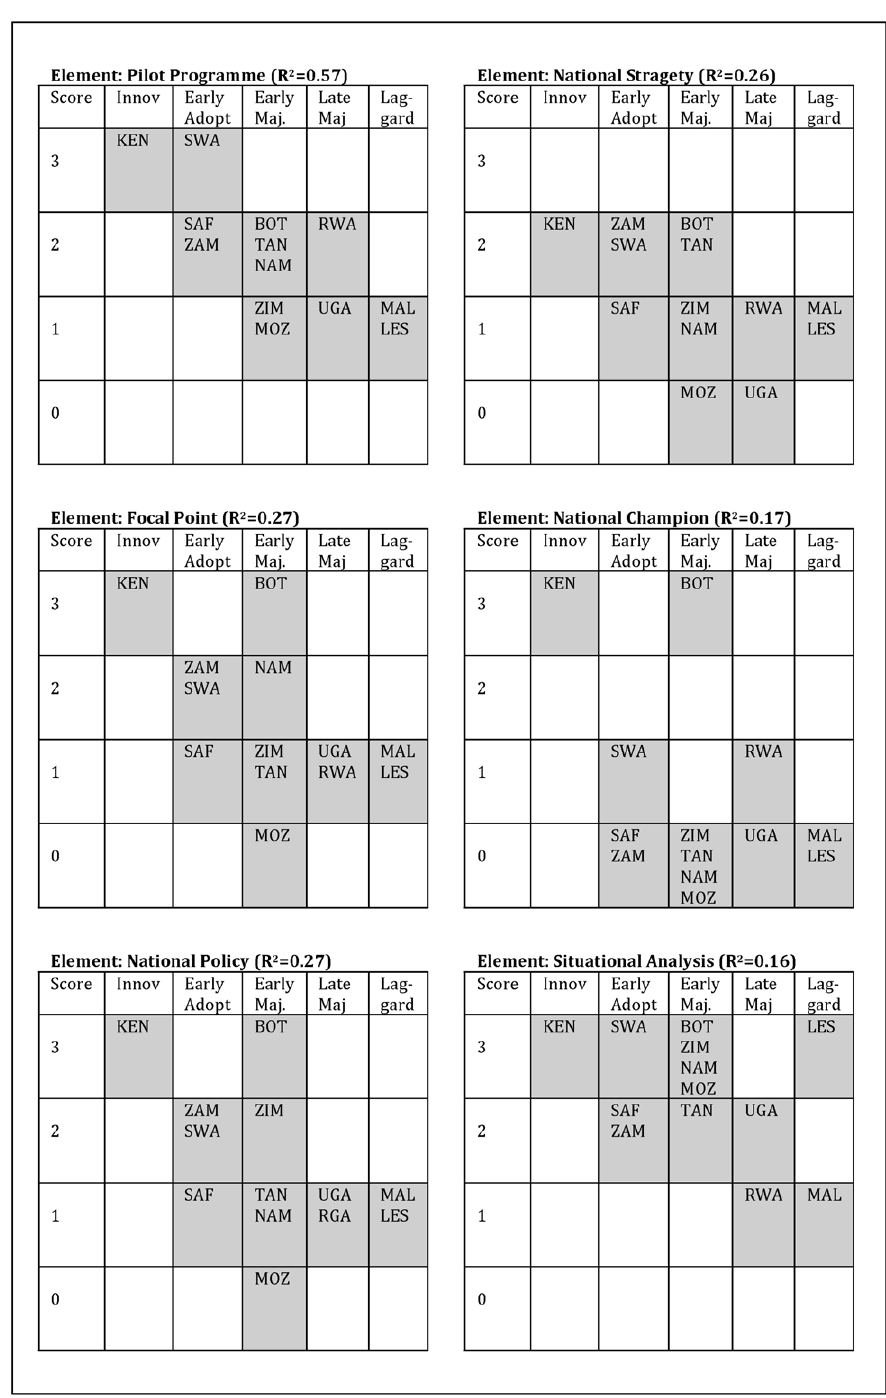
Figure 3. Association of scale-up element scores and Diffusion of Innovation adoption status. The correlation between each of the six elements of scale-up and DOI adoption status is shown in this figure. The scores obtained (ranging from 0 to 3) for each element by each country is shown (on the vertical axis) in relation to the adoption status (shown on the horizontal axis). Having a pilot program appears to be the strongest predictor of adoption status; this can be seen in the linear clustering of the countries. Conversely, having conducted a situational analysis appears to the least predictive of adoption status; the clustering of the countries is less linear and appears more random. BOT, Botswana; KEN, Kenya; LES, Lesotho; MAL, Malawi; MOZ, Mozambique; NAM, Namibia; RWA, Rwanda; SAF, South Africa; SWA, Swaziland; TAN, Tanzania; UGA, Uganda; ZAM, Zambia; ZIM, Zimbabwe.